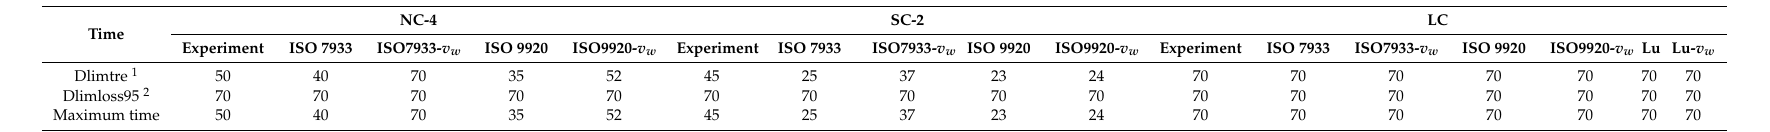
Note: 1 Dlimtre is the maximum time determined by rectal temperature, 2 Dlimloss95 is the maximum time determined by water